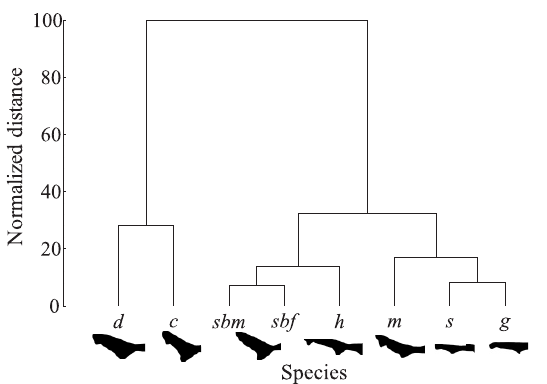
Fig . 6. – Dendrogram of the seven investigated demersal sharks us- ing UPGma clustering from euclidean distances based on median values per species of body size-standardised caudal fin span and area, tail aspect ratio, hepatosomatic index and muscular-skeletal amount per unit length for Galeus melastomus ( g ), Scyliorhinus can- icula ( s ), Heptranchias perlo ( h ), Squalus blainvillei ( sbm : males; sbf : females), Mustelus asterias ( m ), Centrophorus uyato ( c ) and Dalatias licha ( d ). the normalised distance is (linkage distance)/